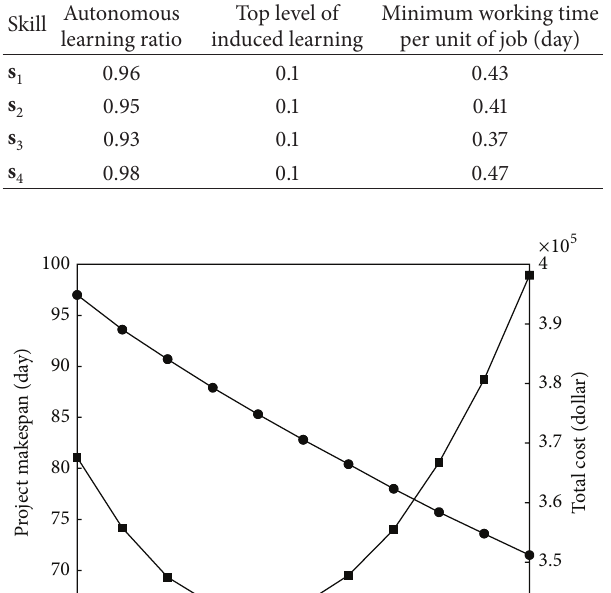
Table 3: Learning parameters on skills.